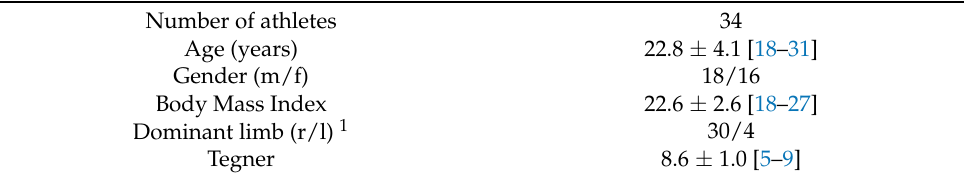
Table 1. Demographic data, mean ± SD